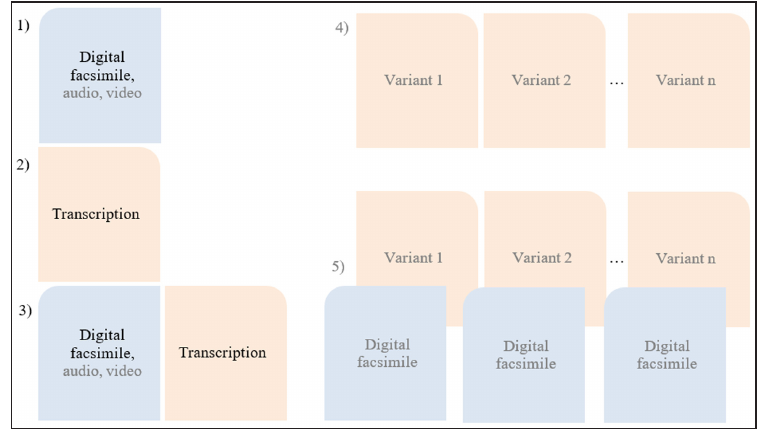
Figure 3: Transviewer configuration schemes. The light blue squares with a rounded top-left corner represent digitised forms of the original (image facsimile, digitised audio or video footage), while the light orange squares with a rounded top-right corner represent transcriptions or different variants of the original in textual